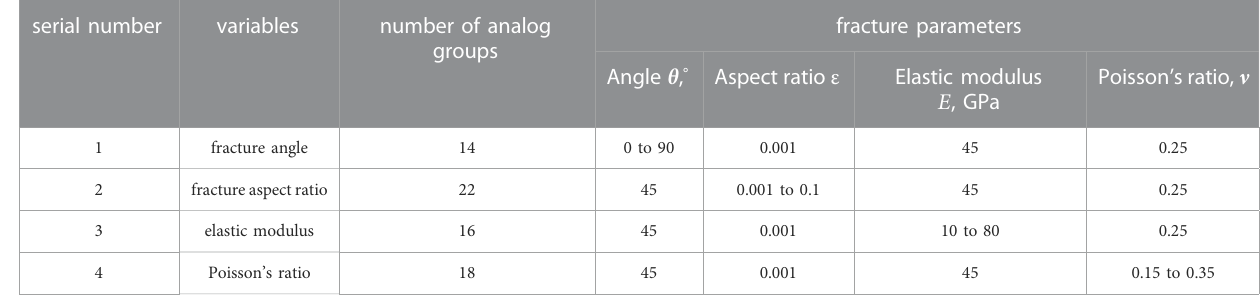
TABLE 2 List of performed numerical experiments.